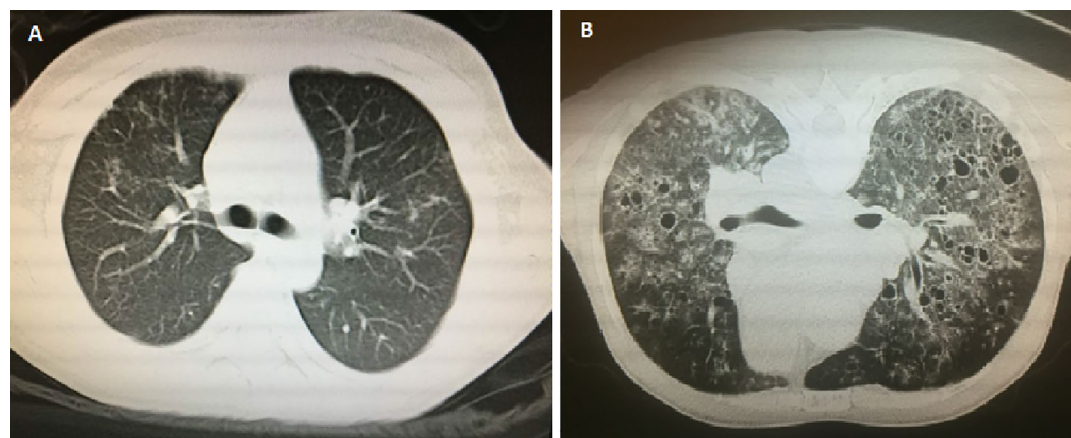
Figure 1. Typical imaging of DAH ( A ) and ILD ( B ) from our PRS